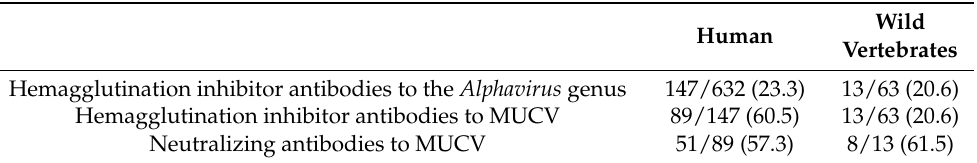
Table 1. Serological results, detection of Alphavirus and MUCV antibodies (HI), and MUCV neutraliz- ing antibodies in the investigated